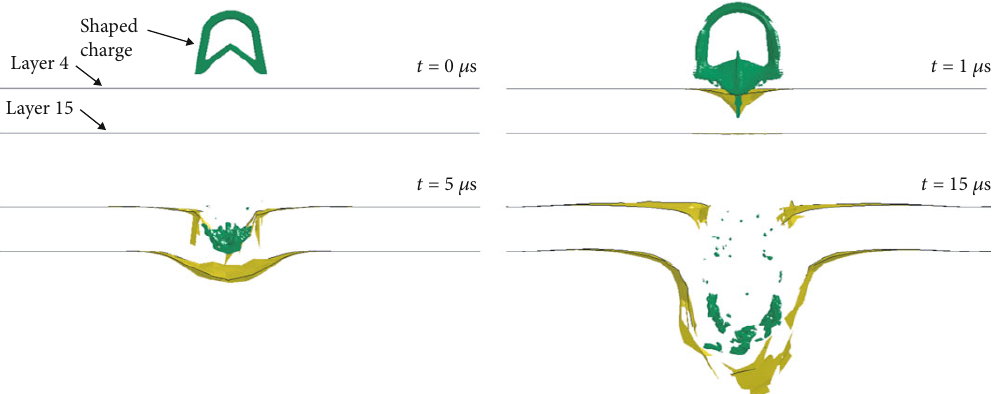
Figure 12: Cutting process of the sublayer.